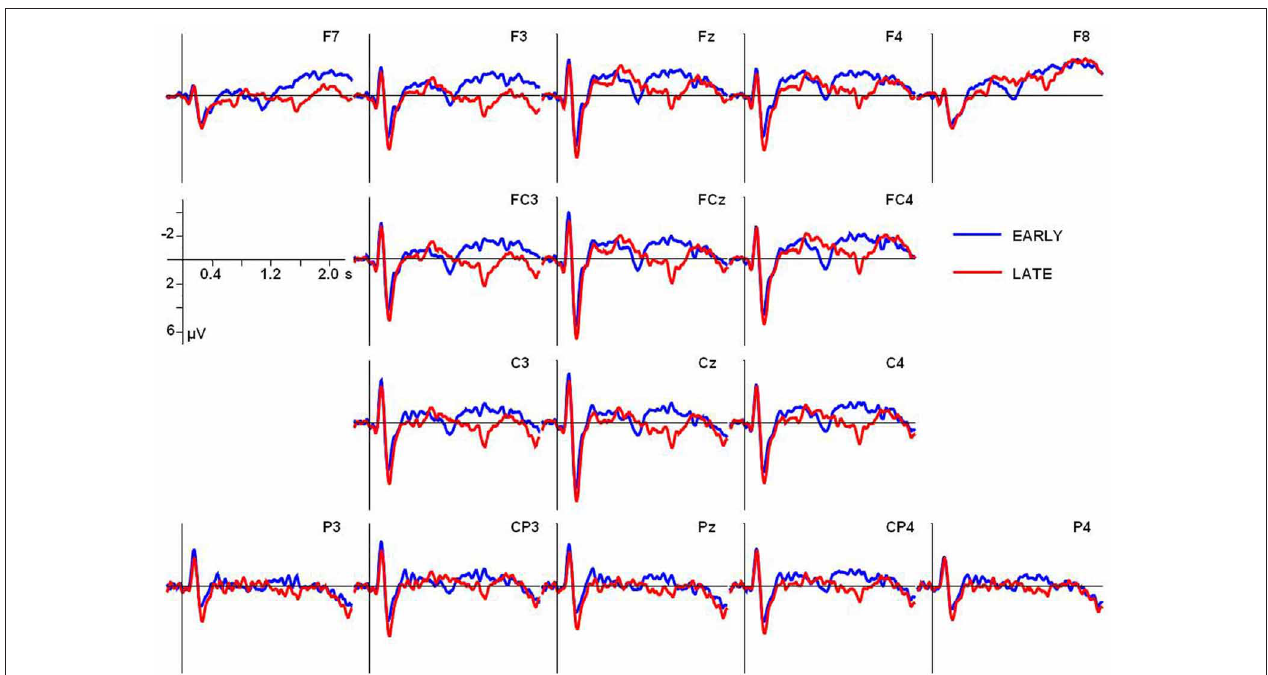
FIGURE 2 | Grand average ERPs adjusted to a prestimulus baseline of 200ms for both conditions at the electrodes used in the statistical analyses. In all ERP figures an 8-Hz